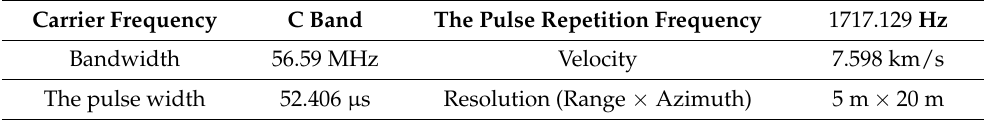
Table 4. Parameters of the spaceborne SAR